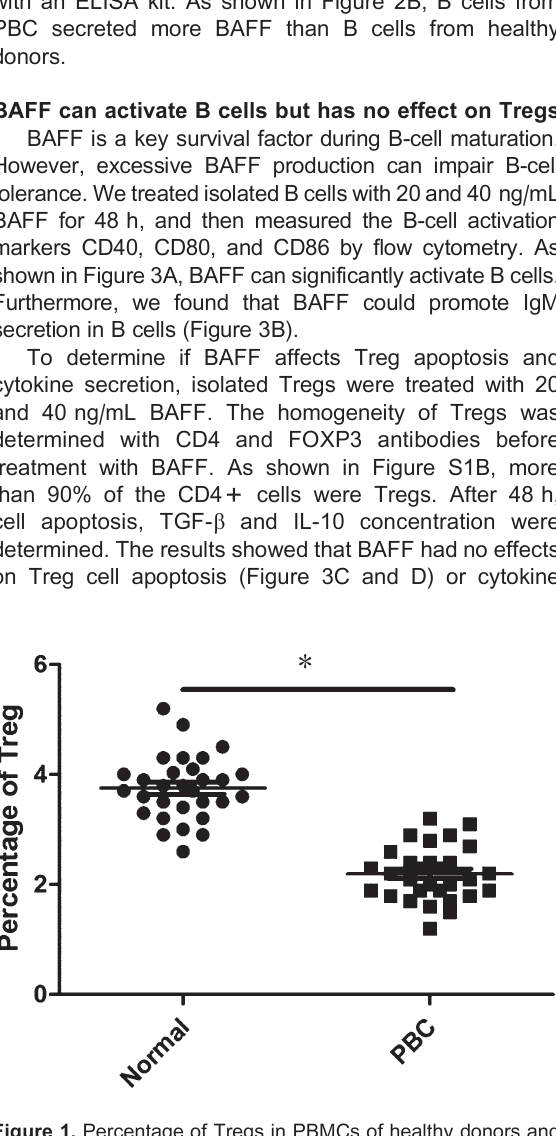
Figure 1. Percentage of Tregs in PBMCs of healthy donors and PBC patients. PBMCs were collected from 30 PBC patients and 30 healthy donors and stained with FITC-conjugated anti-CD4, PE-Cy5-conjugated anti-CD25, and PE-conjugated anti-FOXP3, according to the manufacturer protocol. CD25++ FOXP3++ Tregs of donors (mean ± SE = 3.751 ± 0.106) and patients (mean ± SE = 2.914 ± 0.089) were identified within gated CD4++ T cells. Tregs = regulatory T cells; PBMCs = peripheral blood mono- nuclear cells; PBC = primary biliary cirrhosis. *P , 0.05 vs normal (two-tailed Student t